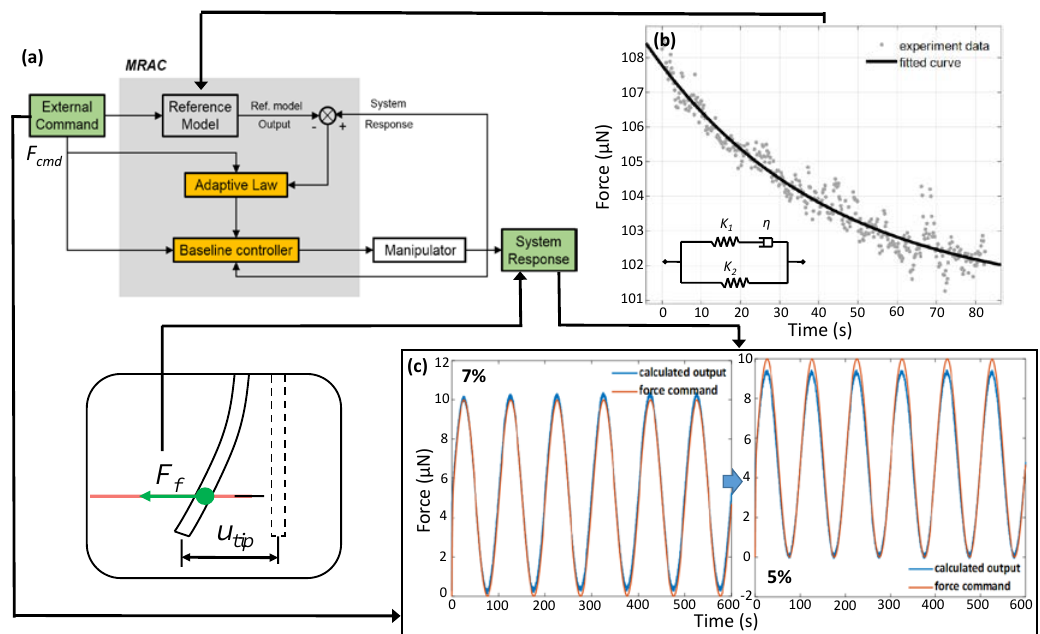
Figure 3. The stretching force control strategy. ( a ) Block diagram of the proposed MRAC method. ( b ) Experimental data fitted with SLS model based on 7% w / v GelMA microfiber. ( c ) Simulation results of MRAC with microfiber with 7% and 5.5% w / v GelMA microfiber.